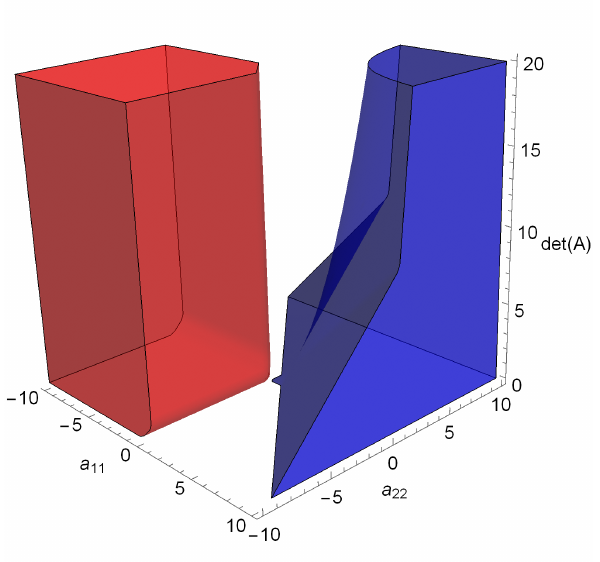
Figure 8. The fractional-order-independent stability (red) and instability (blue) regions R s and R u provided by Theorems 4 and 5 for system (15).